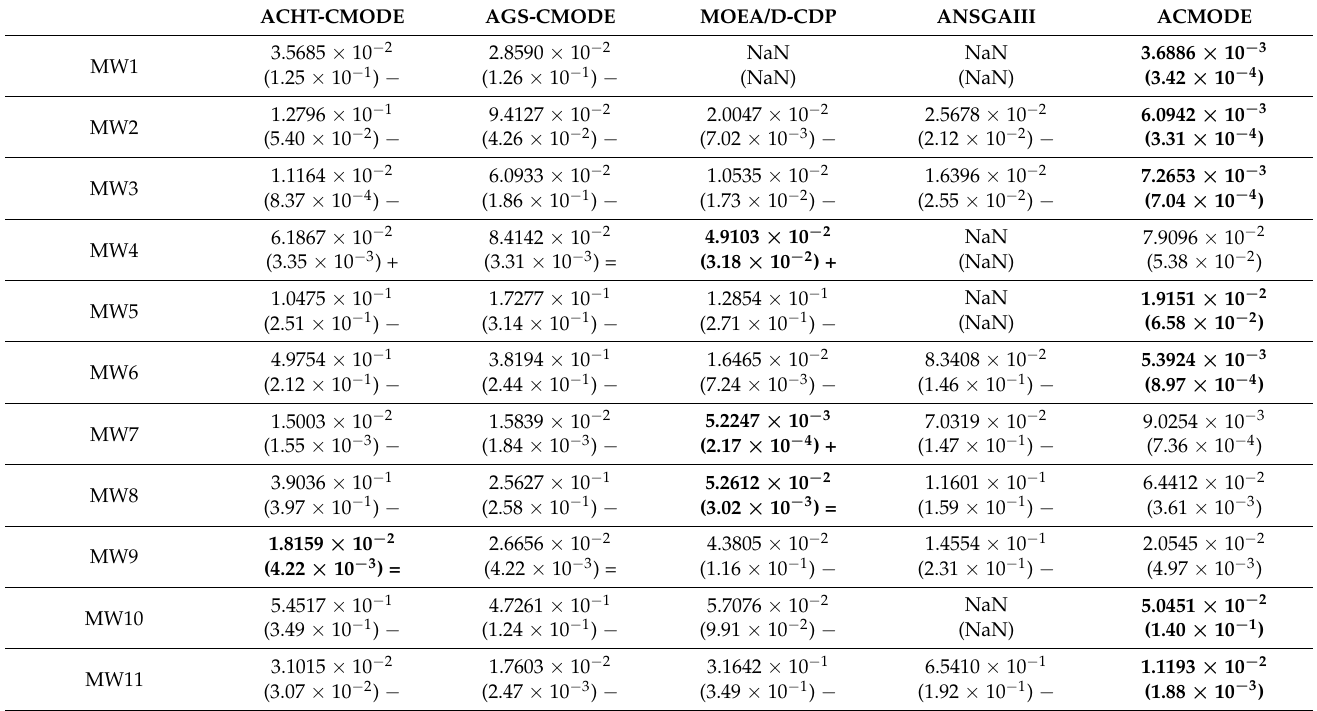
Table 8. IGD results of all comparison algorithms on MW test